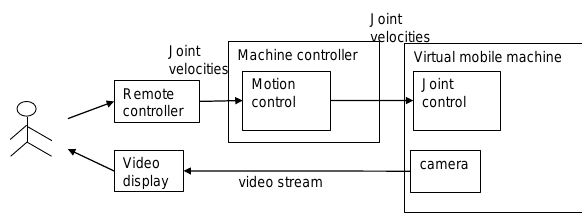
Figure 3: Remote control of a virtual machine: feedforward joint velocity